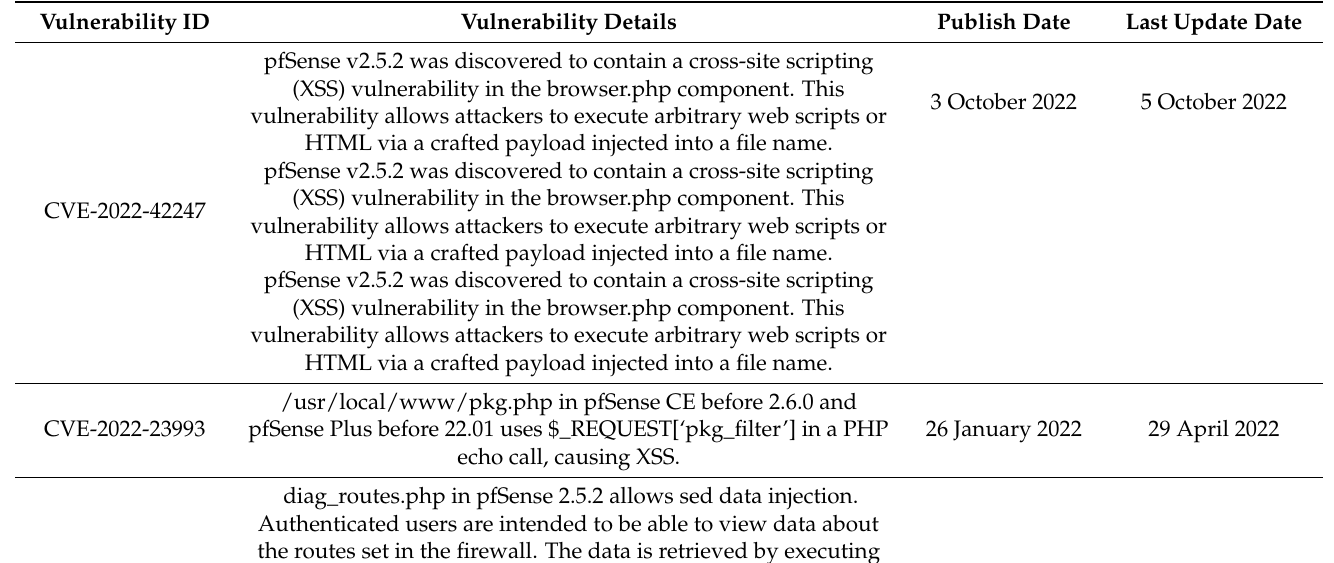
Table 1. pfSense security